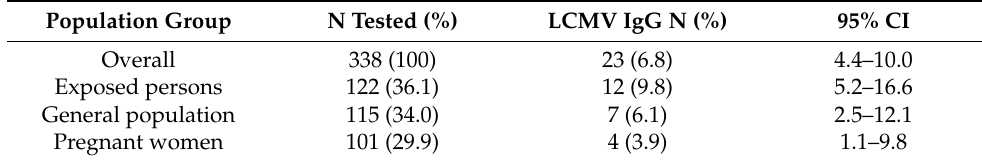
Table 1. Seroprevalence of LCMV in continental Croatia .